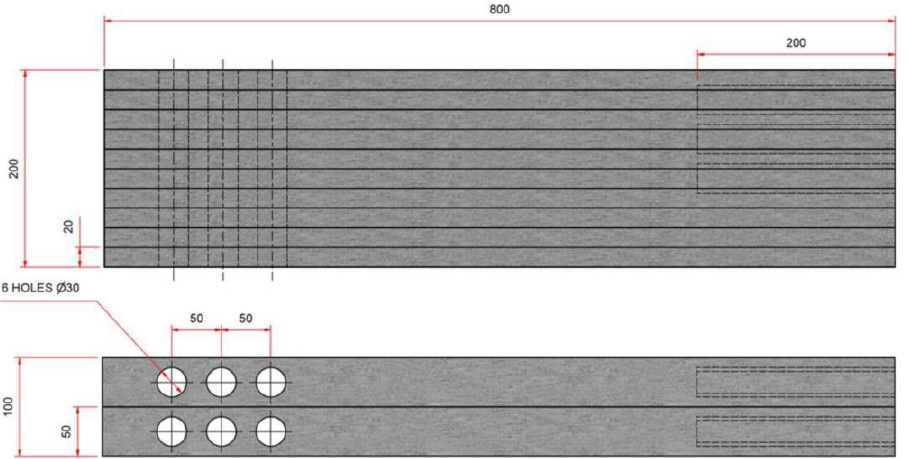
Figure 2. Positions and orientations of cored specimens from the printed elements. OI specimens are shown on the left and OIII on the right. The top image depicts a front elevation view and bottom image plan view. Units in mm.